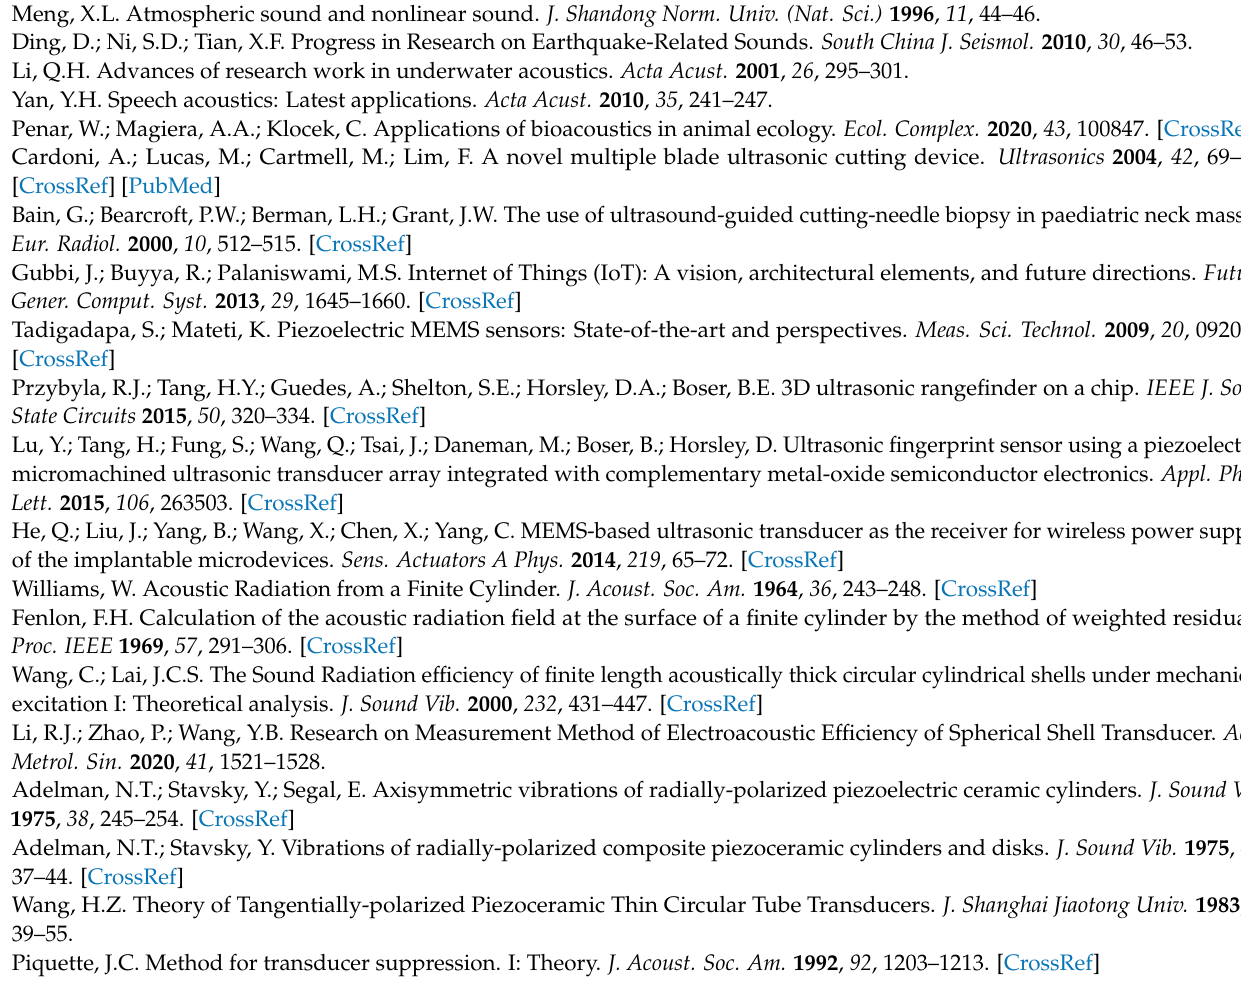
system, Figure S2: the hardware of multifunctional acoustic-measurement instrument, Figure S3: the human-machine interface of the measurement system, Figure S4: the silencing tank filled with